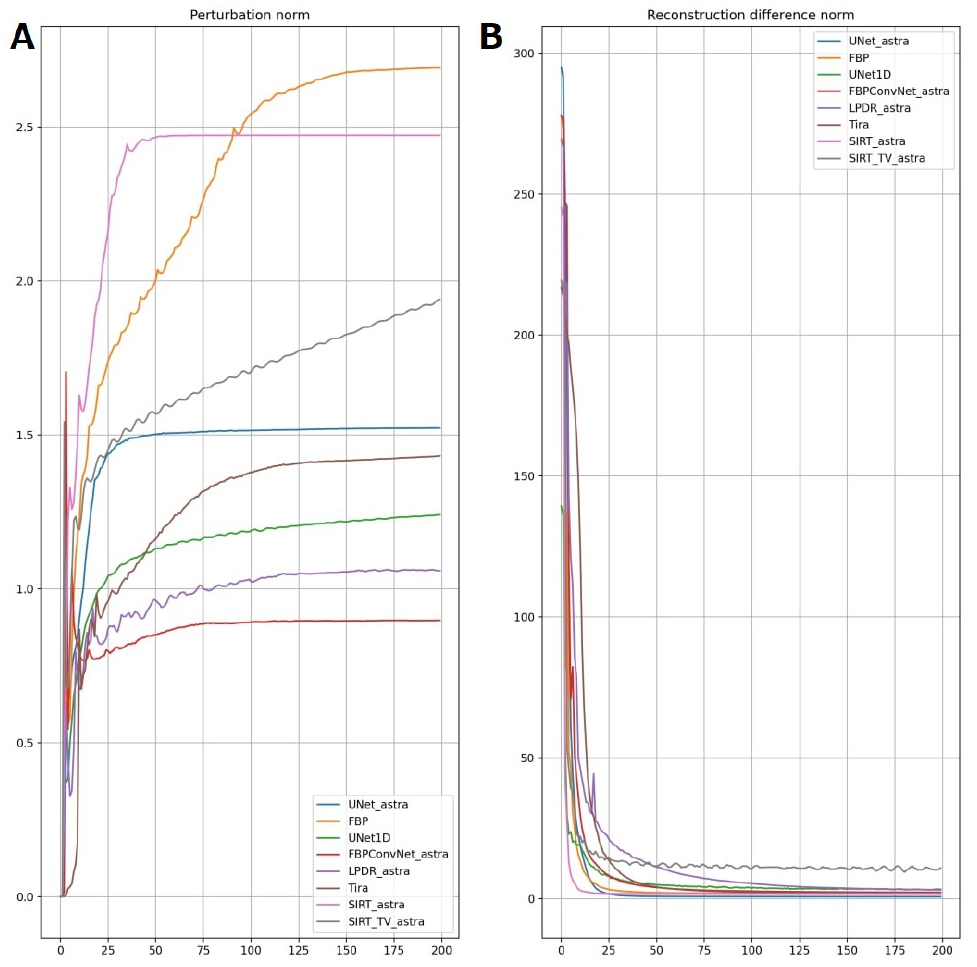
Figure 6. ( A ) Sinogram perturbation norms versus iteration number of the optimizing algorithm L-BFGS for various reconstruction algorithms. ( B ) Target reconstruction error rate from (10) versus the L-BFGS iteration number for various reconstruction algorithms. All plots are provided for the reconstructed images shown in Figure